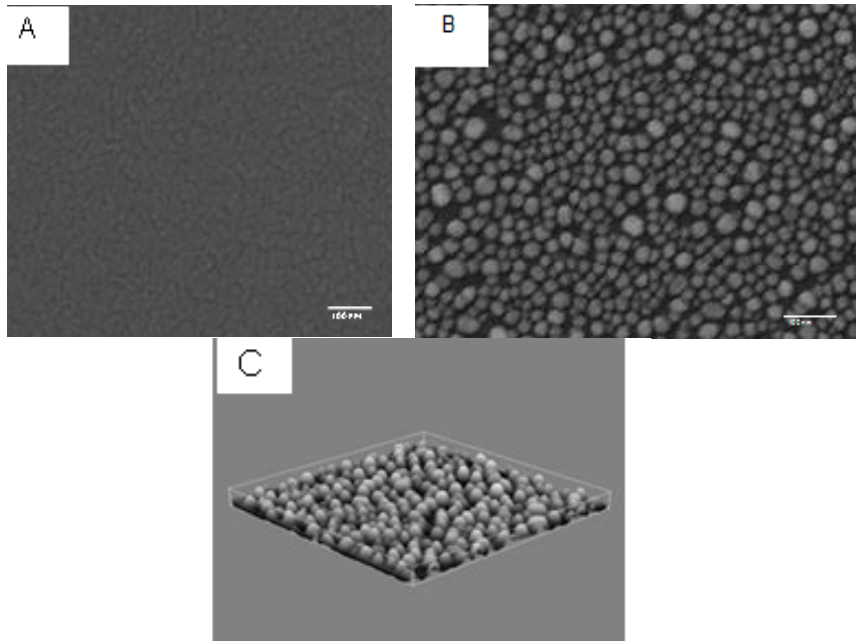
Figure 2. SEM images of a gold film ( A ) evaporated on glass obtained by physical vapor deposition method and ( B ) after annealing at 350 °C, for 1 h, in uncontrolled atmospheric conditions; ( C ) 3D AFM method and ( B ) after annealing at 350 ◦ C, for 1 h, in uncontrolled atmospheric conditions; ( C ) 3D AFM image (5 µm × 5 µm × 40 nm) of SEM image (B). image (5 µ m × 5 µ m × 40 nm) of SEM image